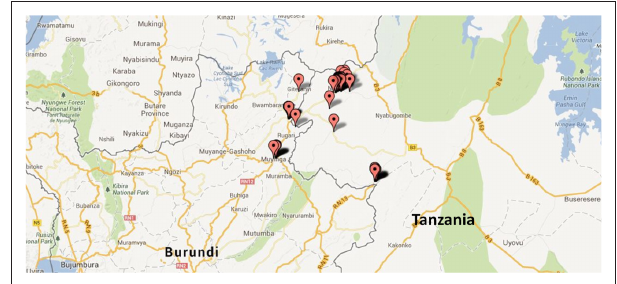
Source : Data from digital forms framework created by the authors, plotted onto Google Maps FIGURE 10: Map showing areas where animal disease cases were reported by livestock field officers between September 2012 and May 2013 in the Kagera River